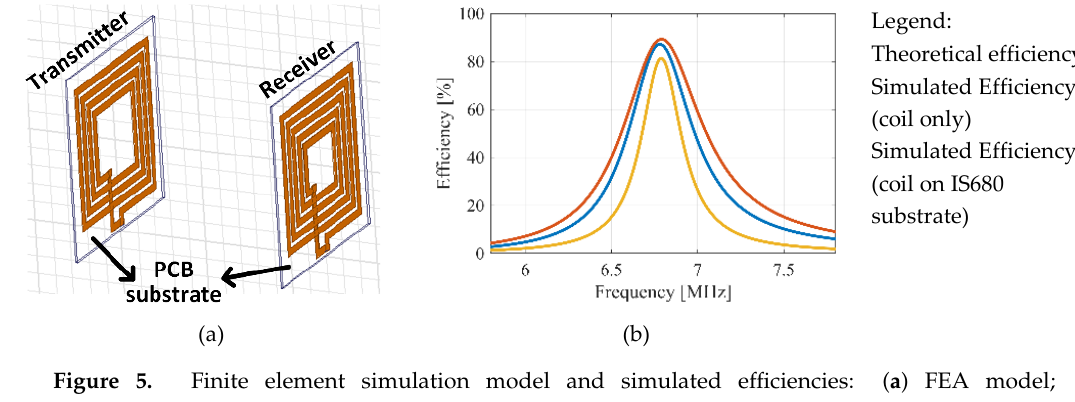
Figure 5. Finite element simulation model and simulated efficiencies: ( a ) FEA model; ( b ) Simulated